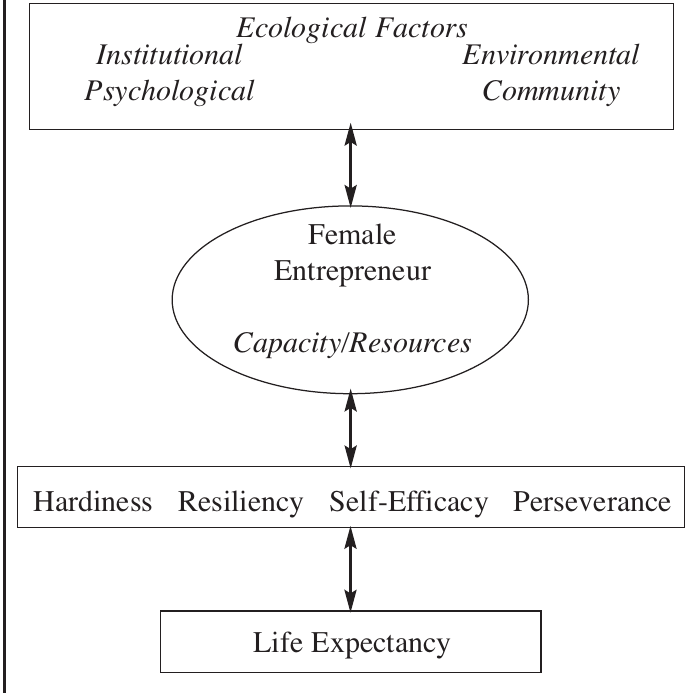
Figure 1. A Conceptual Model of